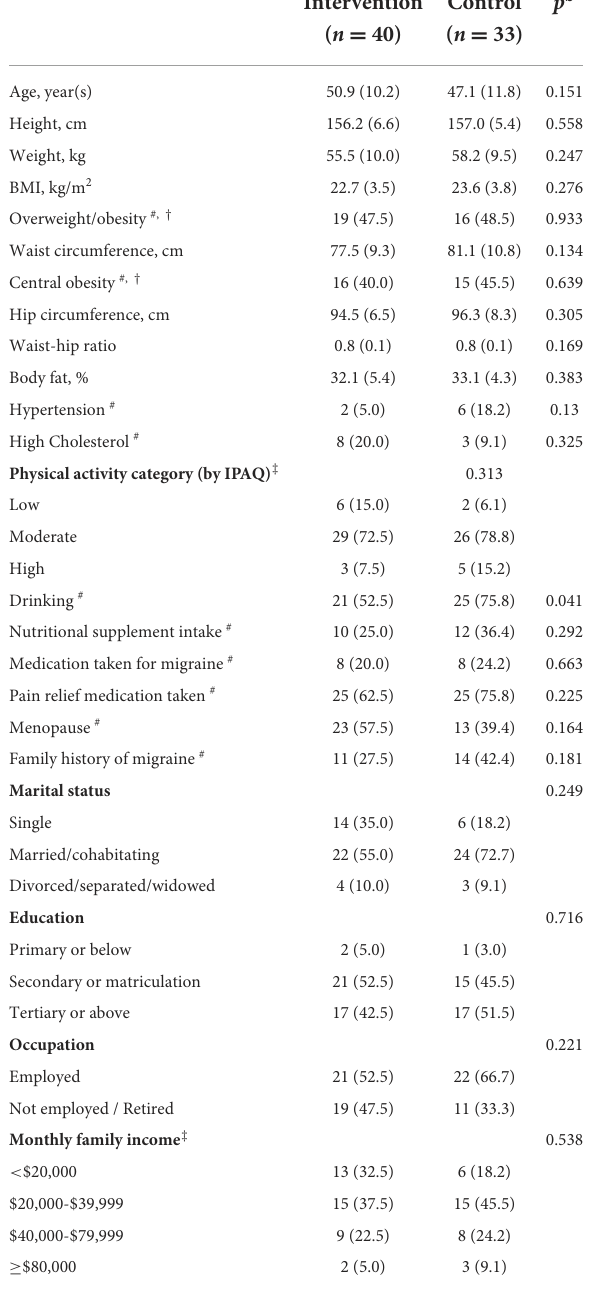
TABLE 1 Basic characteristics of the participants a